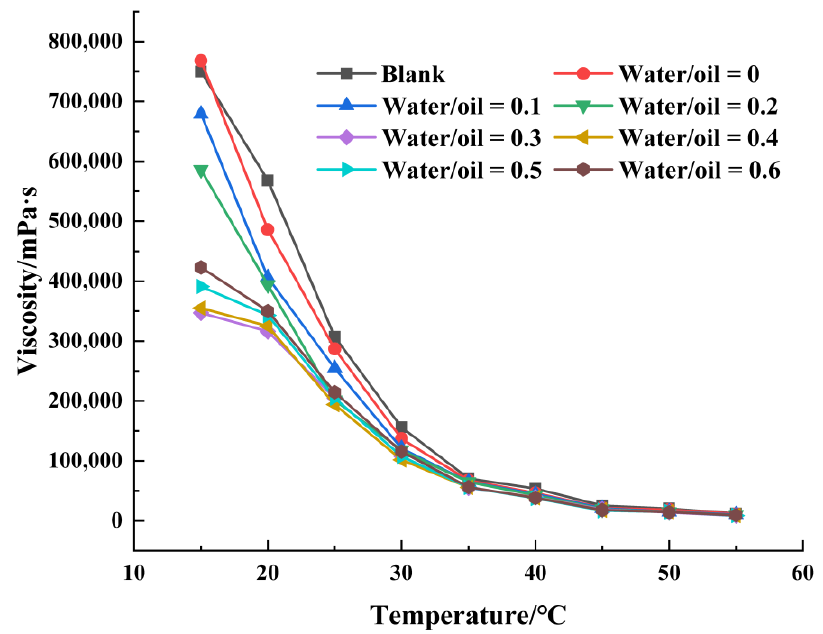
Figure 4. Effect of water on the viscosity of crude oil after aquathermolysis reaction.